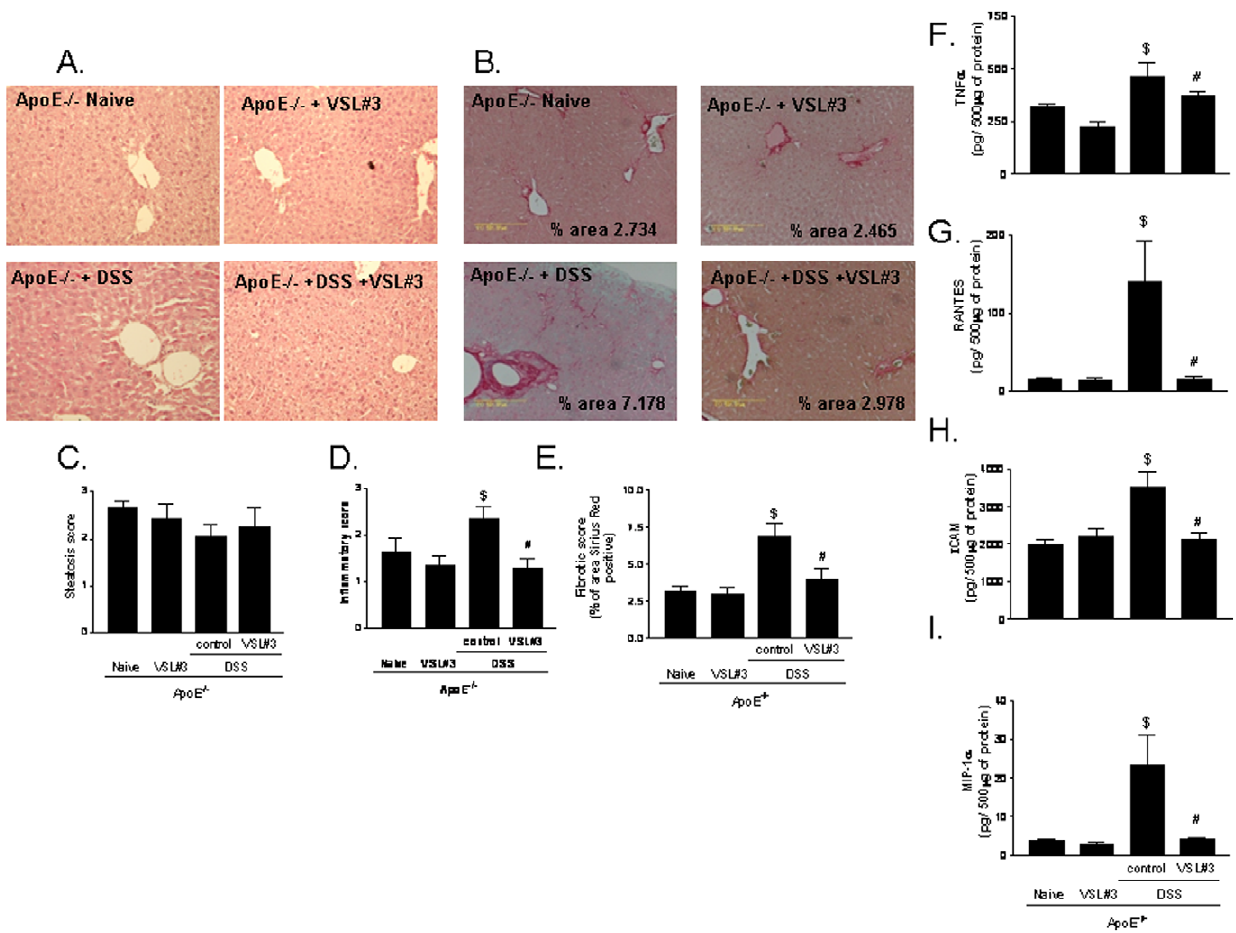
Figure 4. Effect of VSL # 3 on liver inflammation and fibrosis induced by DSS administration. Histopathology analysis of liver, A ) H&E staining and B ) Sirus Red staining; original magnification 20 6 . C ) Steatosis score; D ) Inflammatory score and E ) Fibrosis score. Data are mean 6 SE of n=8–12 mice per group. Liver content of inflammatory mediators including ( F ) TNF a , ( G ) RANTES, ( H ) ICAM-1, and ( I ) MIP-1 a . Data are mean 6 SE of n=5 mice per group. * p , 0.05 ApoE 2 / 2 experimental group versus naive wild type group; ** p , 0.05 ApoE 2 / 2 naı¨ve group versus ApoE 2 / 2 plus VSL # 3 group; $ p , 0.05 ApoE 2 / 2 naive group versus ApoE 2 / 2 plus DSS group; # p , 0.05 ApoE 2 / 2 plus DSS group versus ApoE 2 / 2 plus DSS and VSL # 3